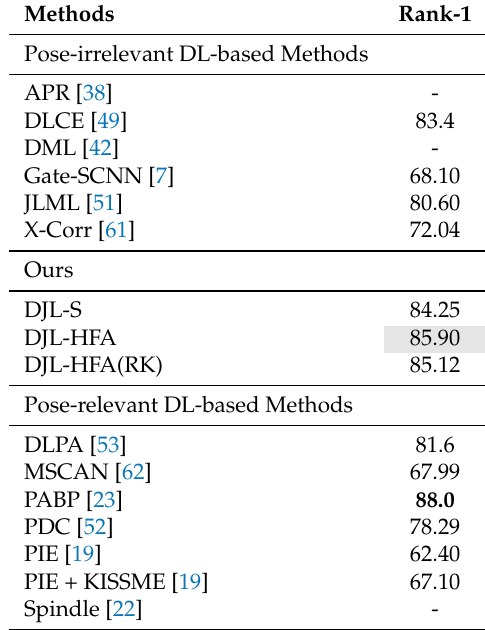
Table 5. Comparison with state-of-the-arts on CUHK03. Rank-1 accuracy (%) is shown. The best result is marked in bold while the second best in